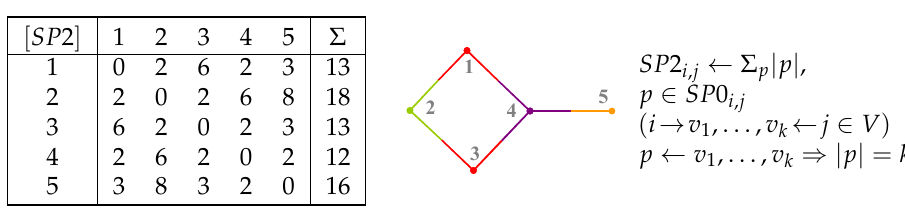
Figure 15. [ SP 1 ] on Figure 1.